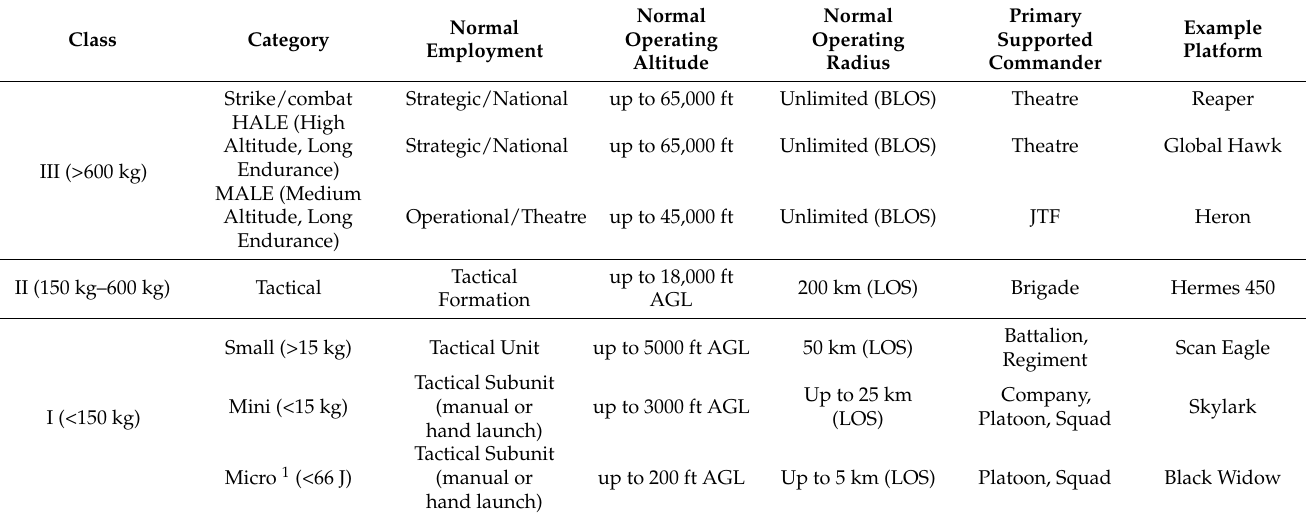
Table 1. NATO Classification of UAS (AGL = Above Ground Level; BLOS = Beyond Line Of